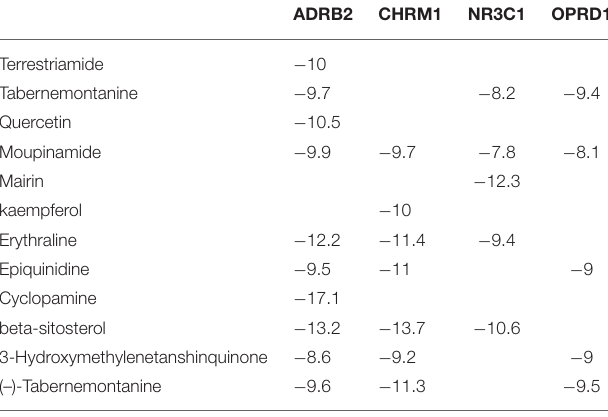
TABLE 2 | Virtual docking of representative ingredients and proteins. ( Figure 4C ). Kaempferol, beta-sitosterol, epiquinidine, (–)- tabememontanine, erythraline, and mouplinamide had highly similar binding sites on CHRM1 ( Figure 4D ). Lysine,